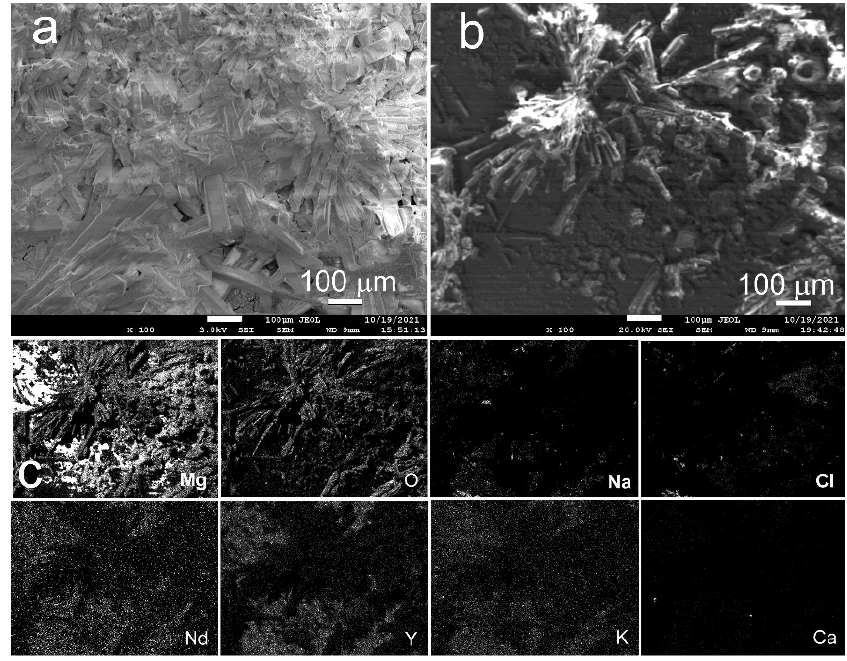
Figure 6. Appearance of degradation products of WE43 Hom. ( a , b ) and elemental mapping ( c ) after 12 days of incubation in FBS.